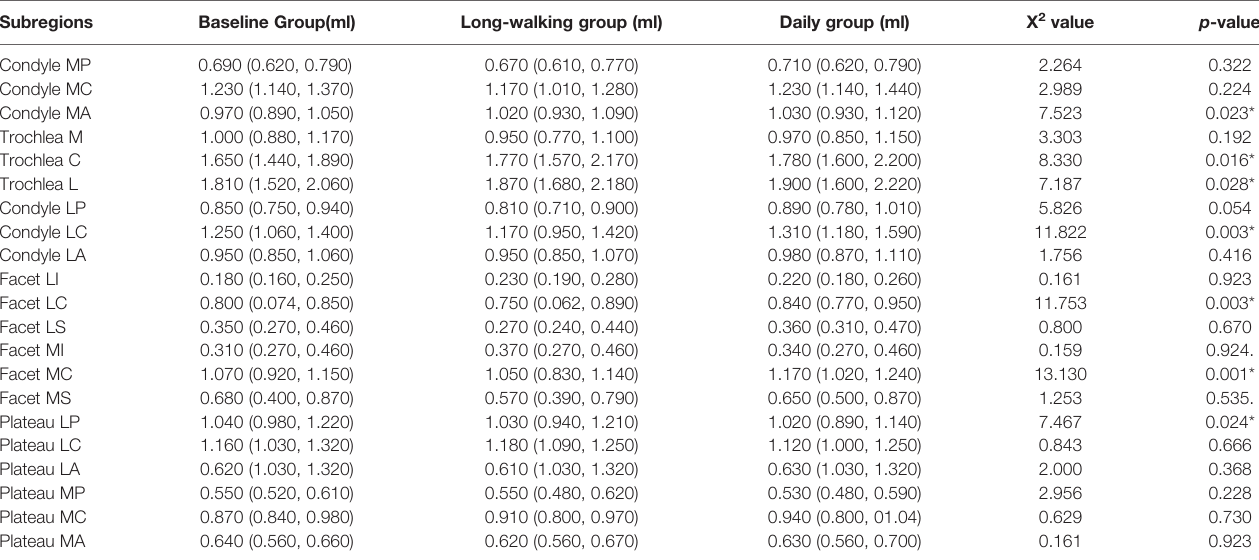
TABLE 4 | Volumes of the 21 sub-regions of the knee cartilage in the three groups.